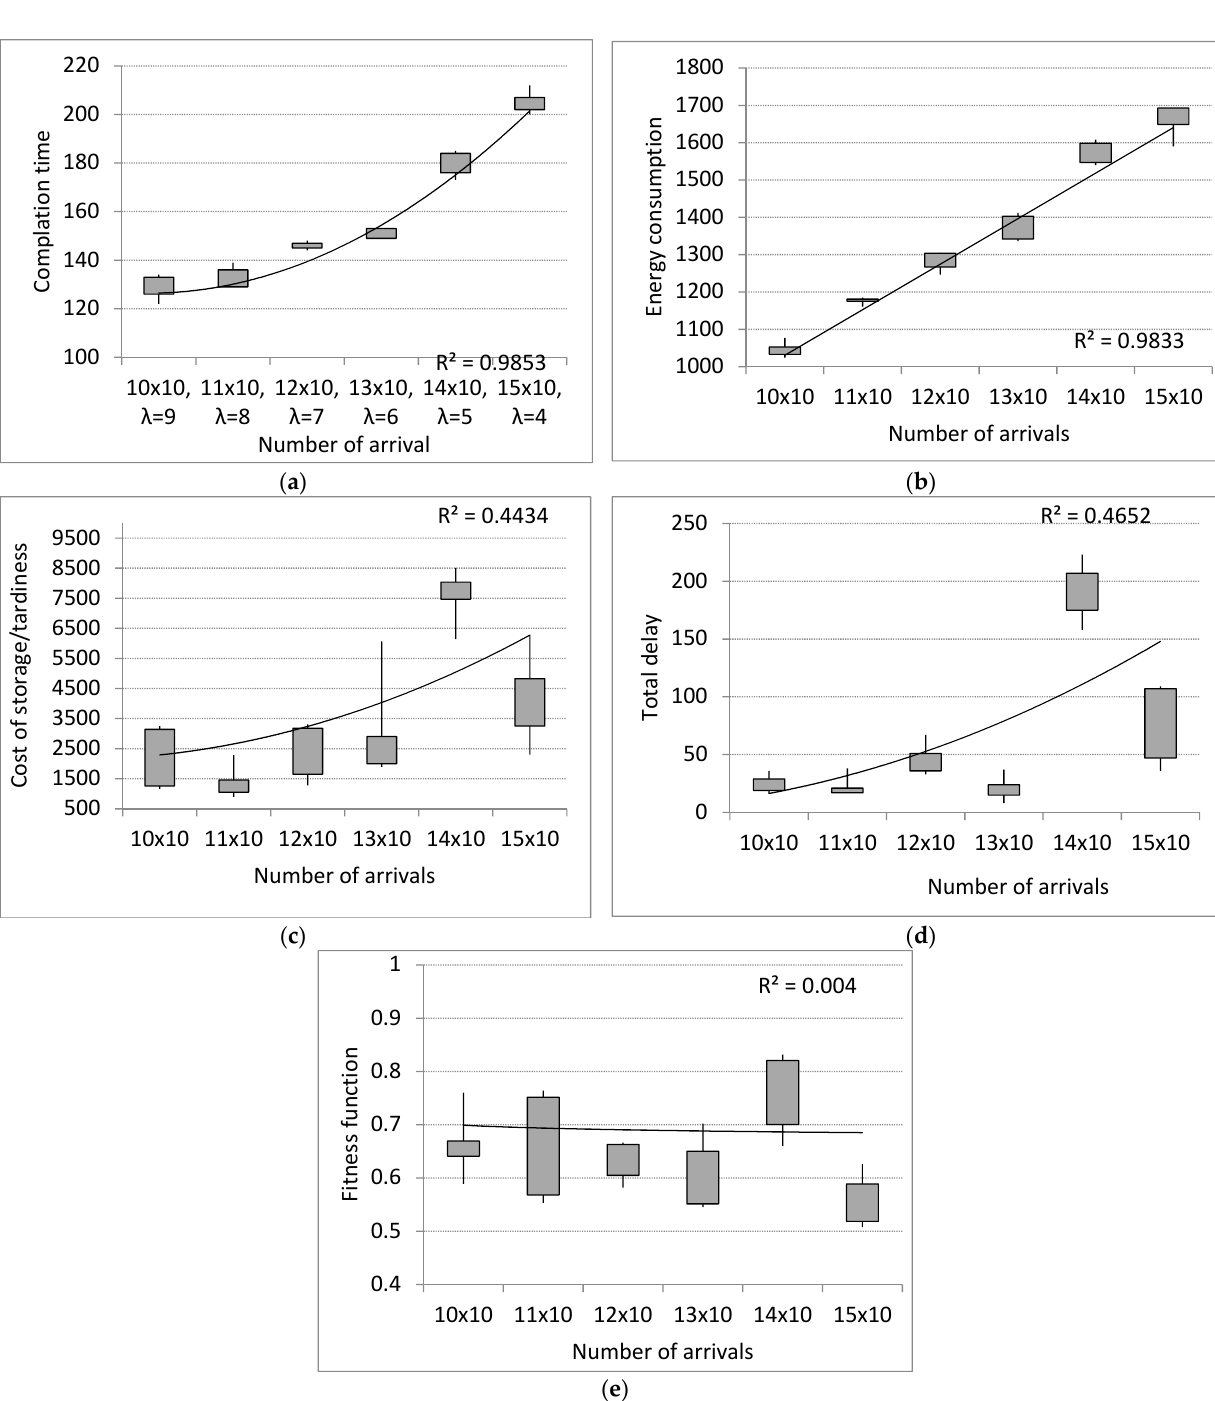
Figure 19. The influence of arrival intensity on ( a ) makespan, ( b ) cost of energy consumption, ( c ) cost of tardiness or premature execution, ( d ) total delay of tasks, ( e ) scalar fitness function for the serial flow.